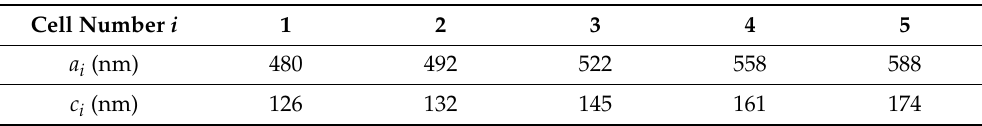
Figure 6. ( a ) Structural tapered function curves a i ( x ) and c i ( x ). ( b ) The normalized electric field E y for the optical guided mode at 198 THz. ( c ) The normalized displacement field | U | for the acoustic guided mode at 5.69 GHz. The normalized thermal profile T of two phases: ( d ) 0, and ( e ) π , which is solved by the thermomechanical FEM for the acoustic mode at 5.69 GHz and room temperature. Table 1. Varied geometric parameters of the cavity cells. Note that the other geometric parameters b , w , and t of the cavity cells are all